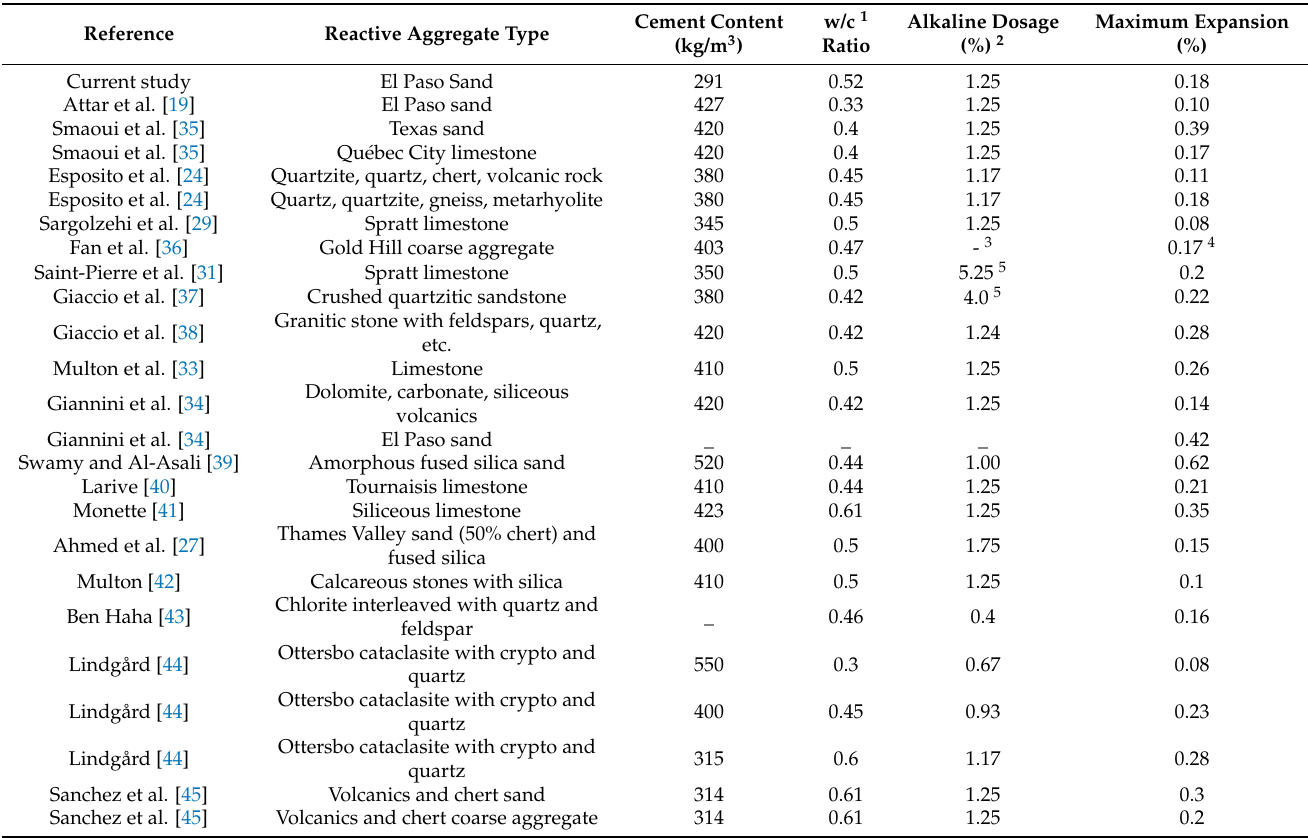
Table 1. List of the studies on ASR-affected concrete properties.